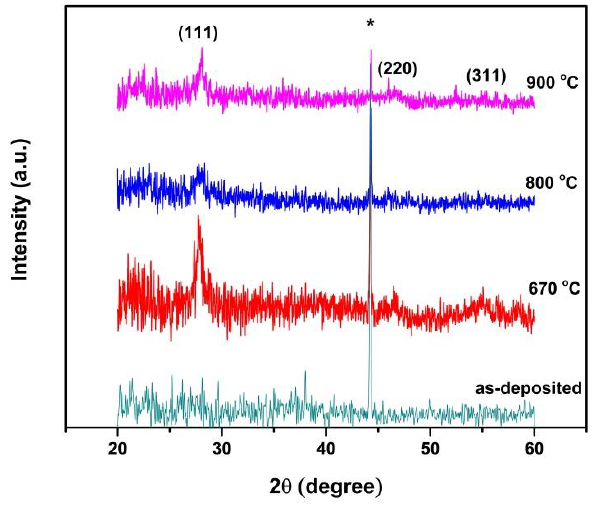
Figure 3. XRD patterns of SiGe/quartz thin films. The peak marked as (*) belongs to sample stage.